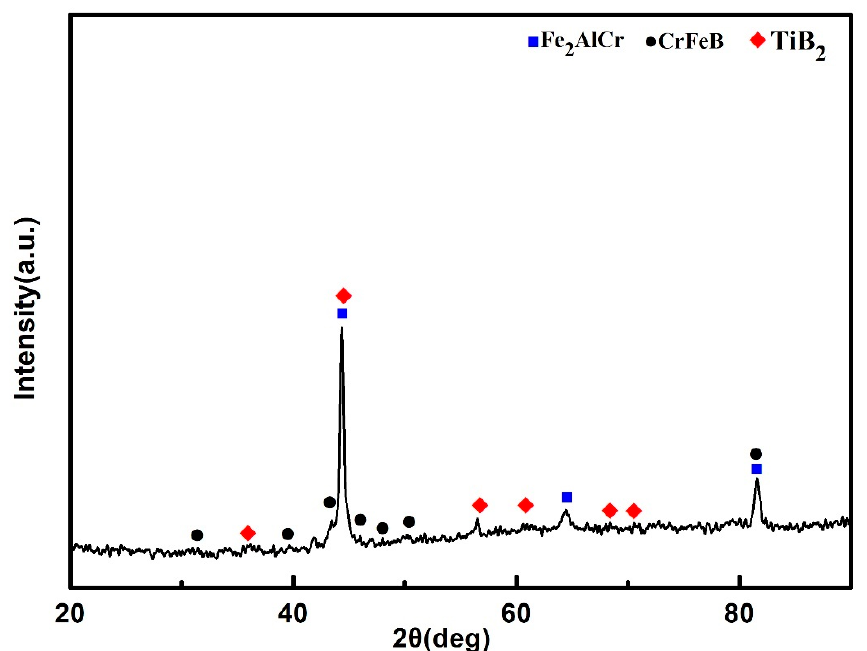
Figure 7. XRD patterns of the 25 vol.%TiB 2 /Fe-15Cr-10Mn-5Al composite sintered at 1100 °C for 10 min under 50 MPa by SPS.